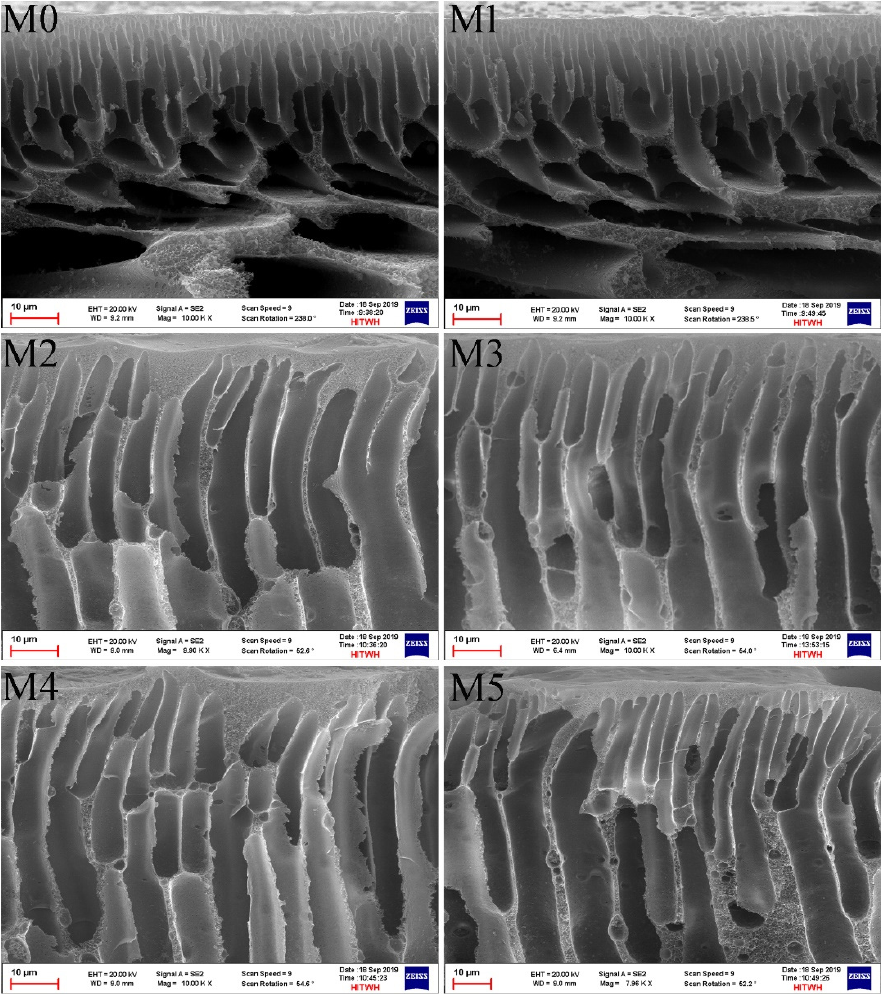
Figure 2. The SEM images of PSf (M0), PSf/PEG (M1), and PSf/PSf-co-SBPSf blend membranes (M2-M5). Table 2. Physical properties of resultant membranes .